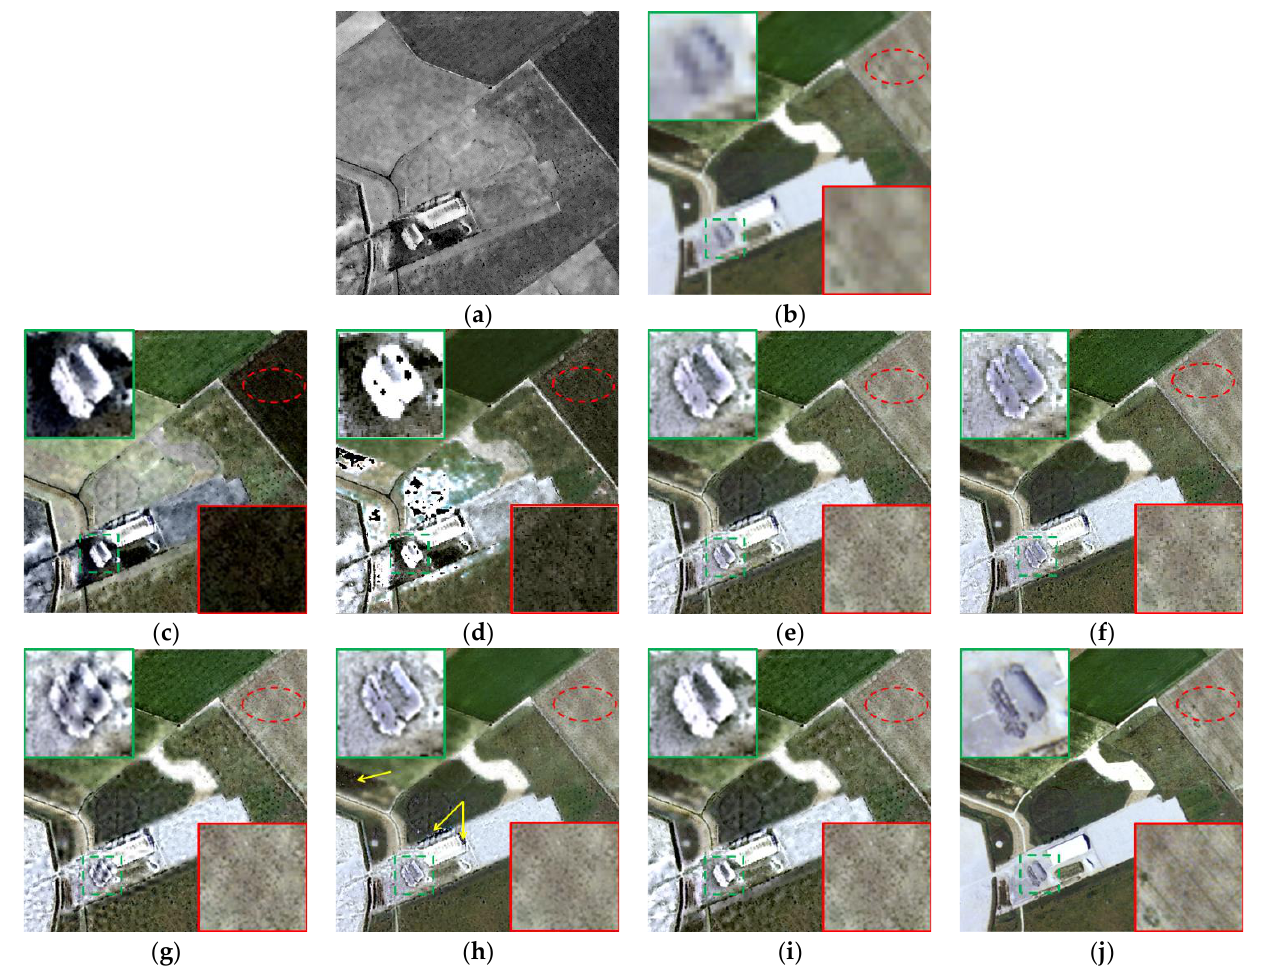
Figure 4. Fusion results of different methods in area 1. ( a ) HR SAR image; ( b ) up-sampled LR multispectral image; ( c ) IHS fusion; ( d ) BTH fusion; ( e ) LP-based fusion; ( f ) AWLPR fusion; ( g ) IW fusion; ( h ) GFTD fusion; ( i ) proposed LPSR fusion; ( j ) original HR multispectral image.